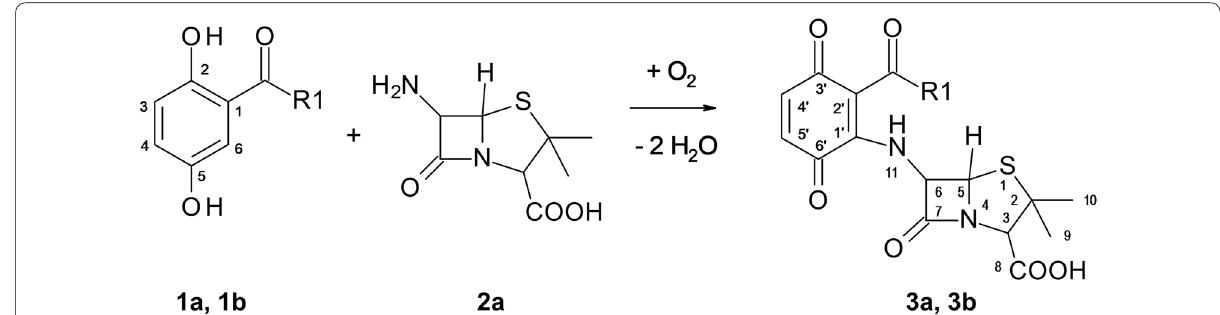
Fig. 1 2,5-Dihydroxybenzoic acid derivatives ( 1a R1 (R1 NH(CH 2 ) 2 OH) and 3b ( R1 =